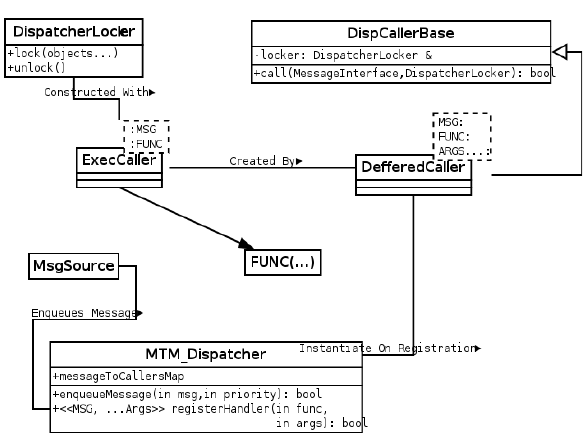
Figure 5. Class Diagram Illustrating Message